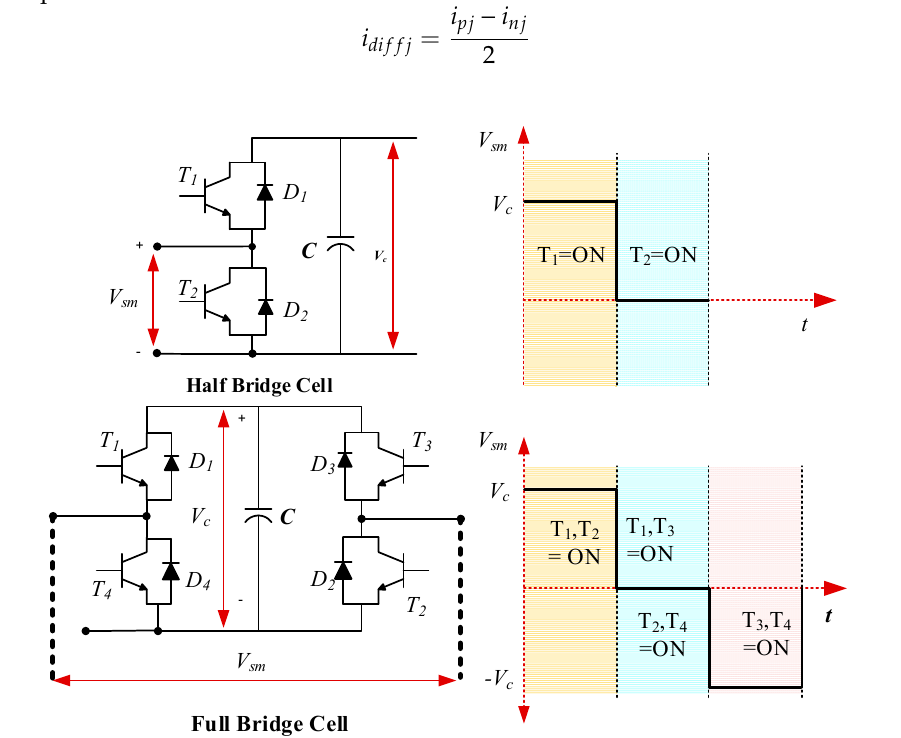
Figure 6. A schematic of the configuration of the MMC based on half-bridge and full-bridge sub-modules (SMs).